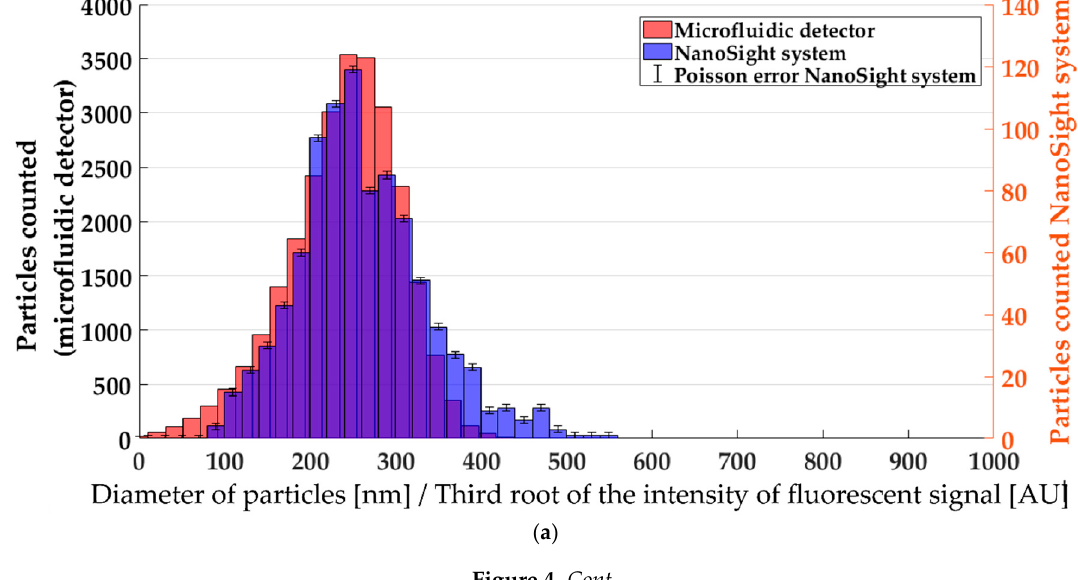
( b ) ( c ) Figure 4. Comparison of qualitative histograms of the third root of fluorescence intensity and particle diameter at different precipitation conditions. The Poisson errors for the microfluidic detector were